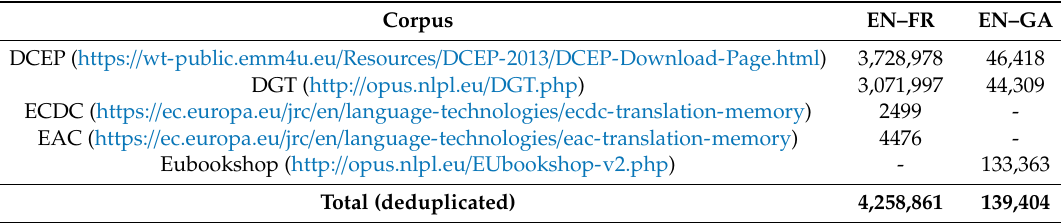
Table 2. Overview of the data used for training of X → EN engines necessary for document alignment and calculation of MAD features. A sample of this data was also used for training of our baseline engines EN → X. Columns two and three show the number of unique sentence pairs (EN–FR, EN–GA). Corpus EN–FR EN–GA